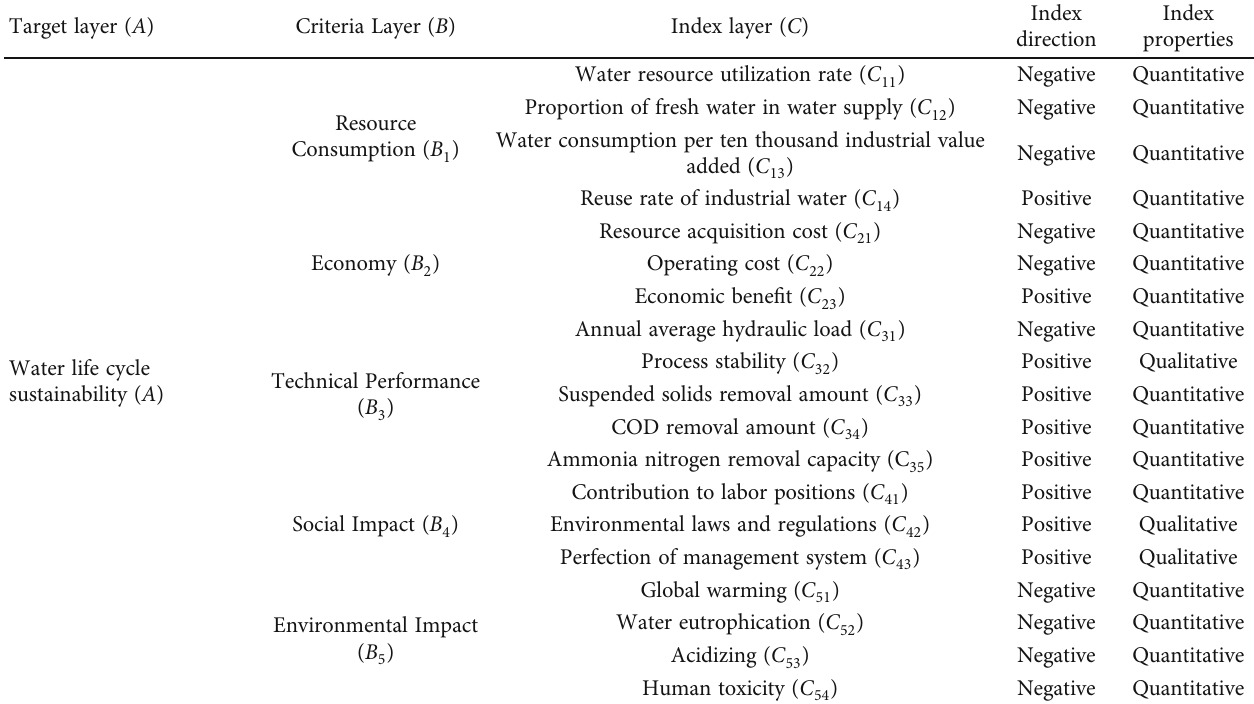
Table 4: Evaluation system of water resource life cycle sustainability in research area.